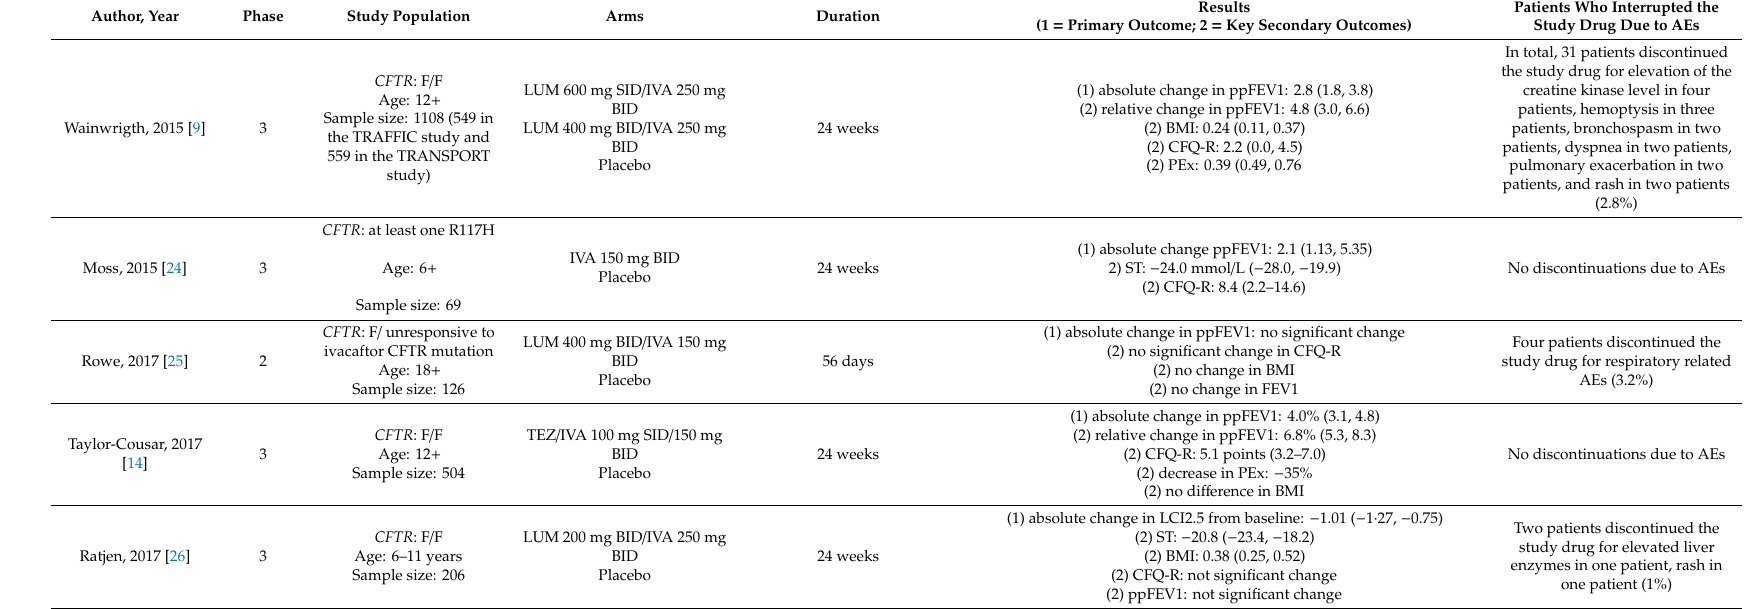
Results (1 = Primary Outcome; 2 = Key Secondary Outcomes)